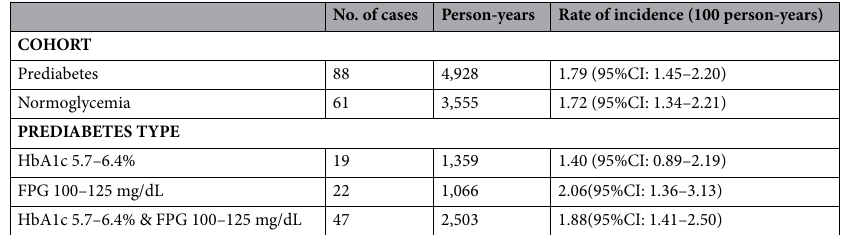
No. of cases Person-years Rate of incidence (100